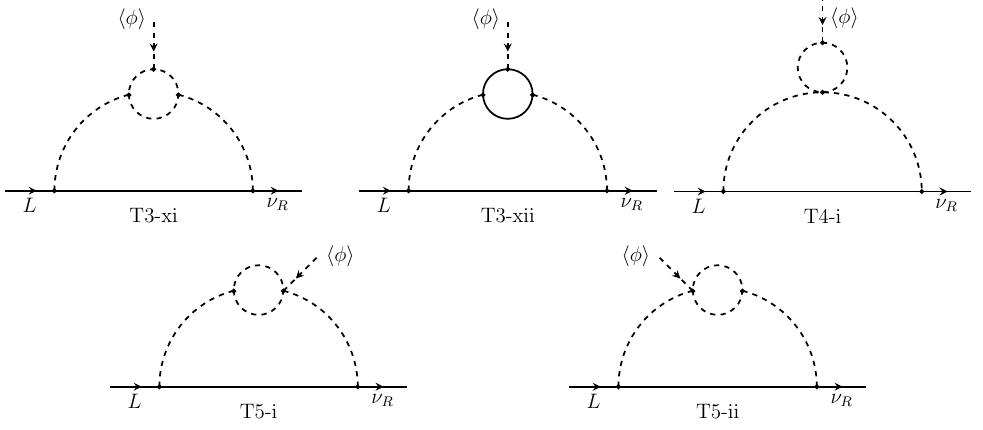
Figure 6 . Diagrams with a compressible scalar-scalar-scalar vertex. All these diagrams contain a one-loop (i.e. non-local) realisation of a 3-point scalar vertex. In each case, the tree-level vertex (cid:30) ( x ) (cid:30) ( x ) S ( x ) is exactly zero, thanks to the fact that the antisymmetric nature of the SU(2) L contraction of the two doublets to a singlet. See (cid:12)gure 5 for